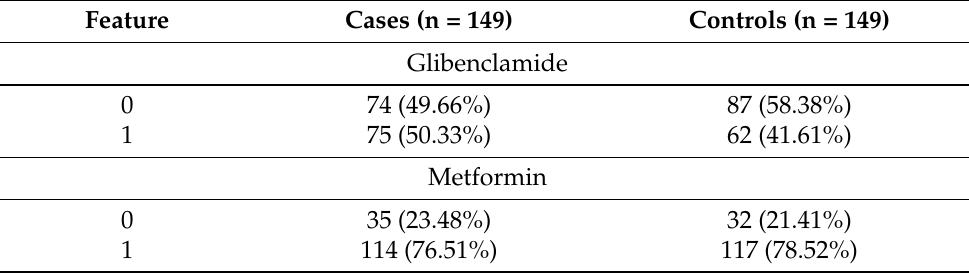
Table 4. Additional information of all the subjects